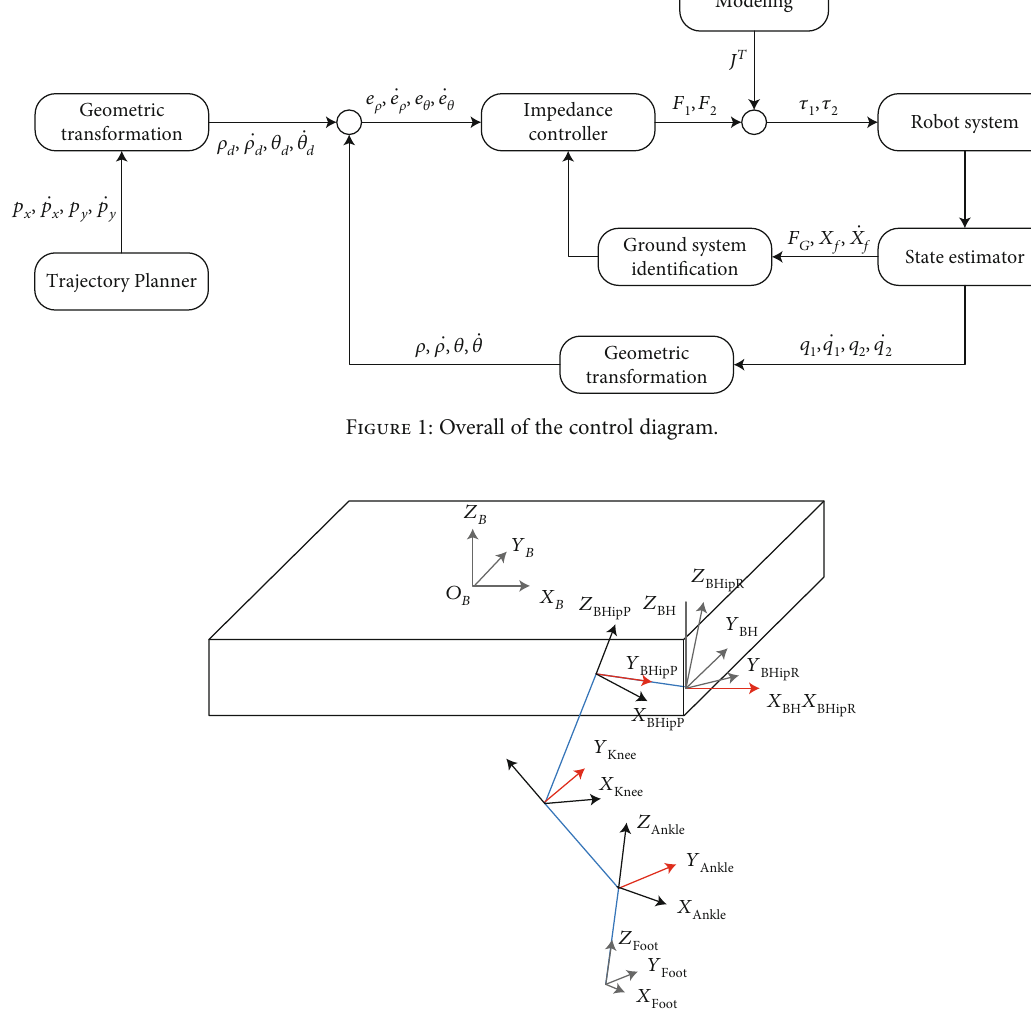
Figure 2: Link coordinate systems for the right front leg of the quadruped